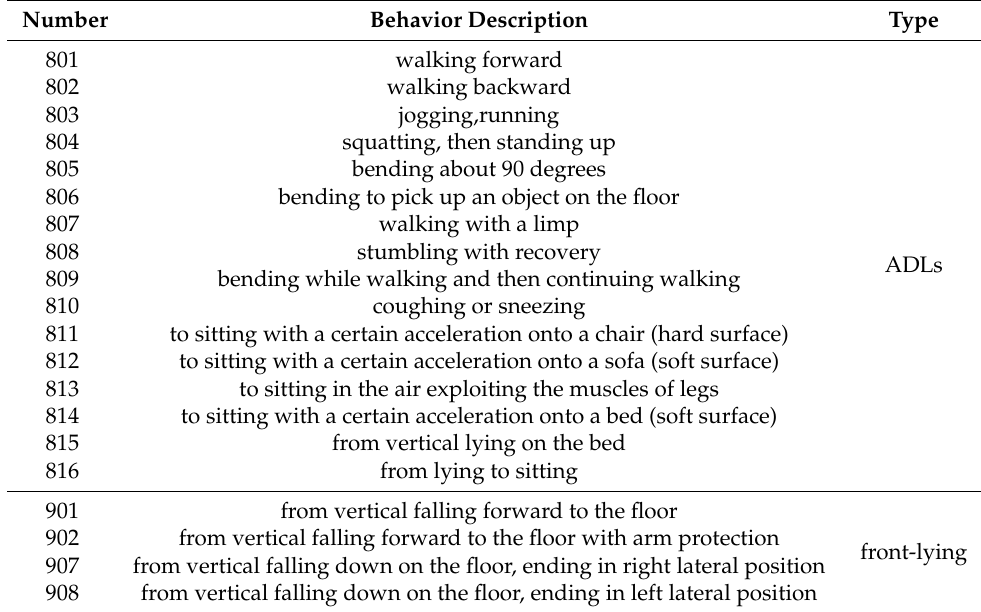
Table 3. Classification of the selected 16 ADLs and 12 fall